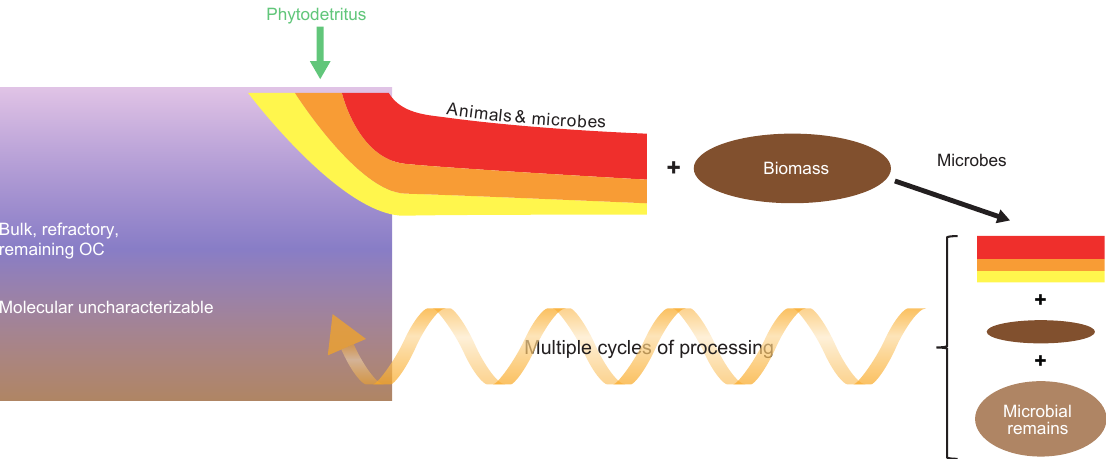
Figure 4. Conceptual diagram showing the relationships between molecular uncharacterizable organics, deposited phytodetritus and sec- ondary production. Phytodetritus is degraded preferentially and new biomass is formed, which after death of the organisms is added to the pool of detritus and subject to degradation. Multiple cycles of organic matter processing eventually result in the formation of molecular uncharacterizable organic matter. The red–orange–yellow fractions of organic matter have a different lability.